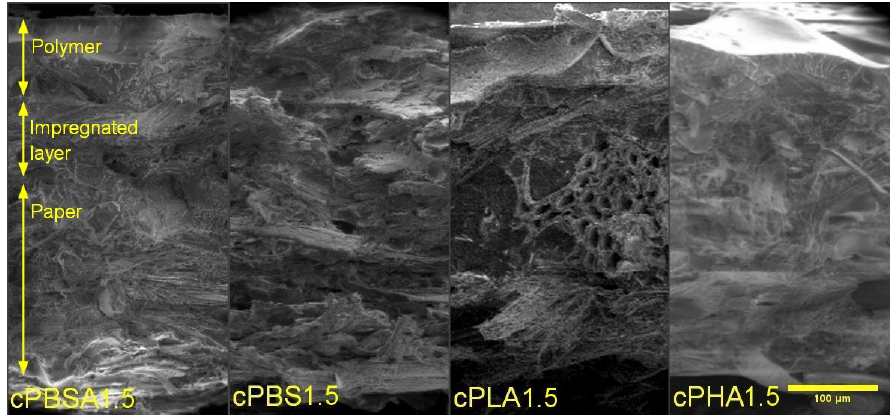
Figure 2. SEM micrographs for laminates prepared with 1.5 MT pressure